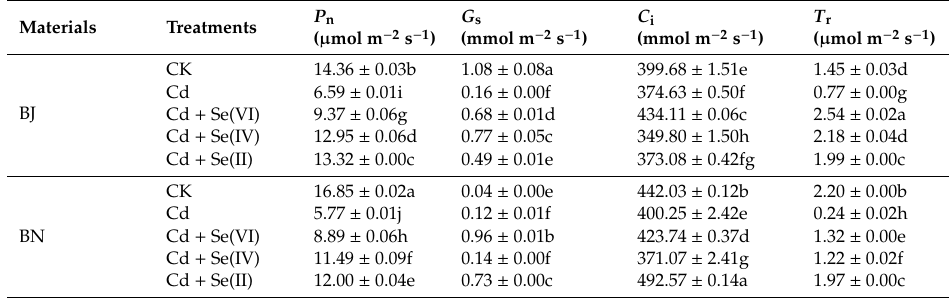
Table 1. Photosynthesis of two Brassica species under the di ff erent treatments. Values are mean ± SD ( n = 3). Di ff erent small letters indicate significant di ff erence at p < 0.05.